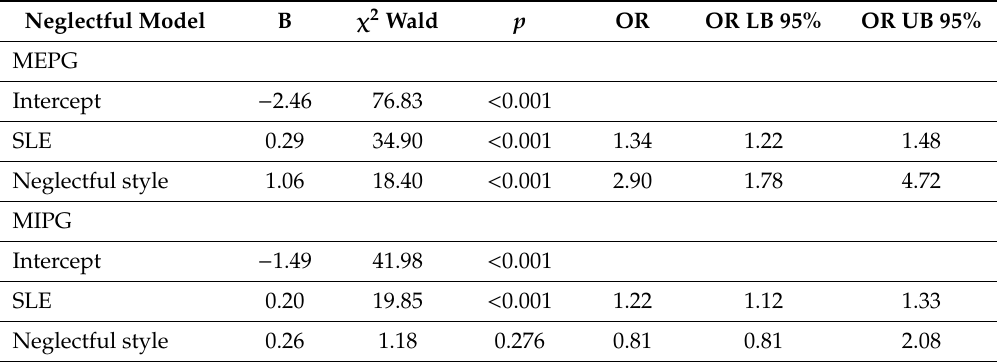
Table 7. Multinomial logistic regression model parameters using the AG as a reference and neglectful style as